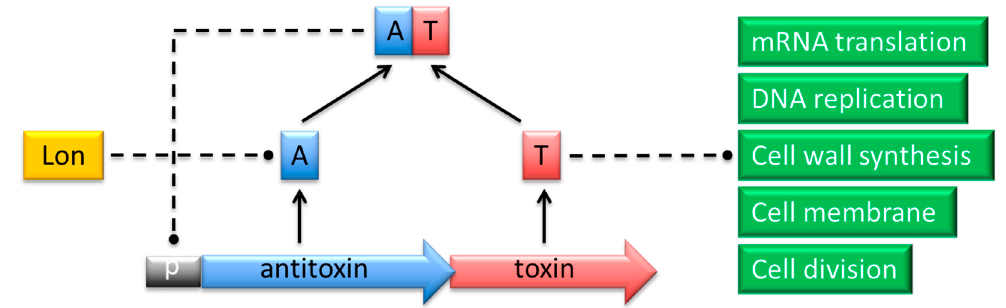
Figure 1. Action of proteins that belong to a typical type II TA complex. The antitoxin (A; blue) and toxin (T; red) genes are co-expressed from a promoter (p; grey) in a single operon. The TA complex negatively regulates transcription from the promoter by binding specific palindromes within the overlapping operator region. In response to certain environmental conditions, the antitoxin is proteolytically cleaved by Lon or Clp proteases (yellow). The toxin is thereby released to act on its specific intracellular target process (green) to induce cell cycle arrest or death.